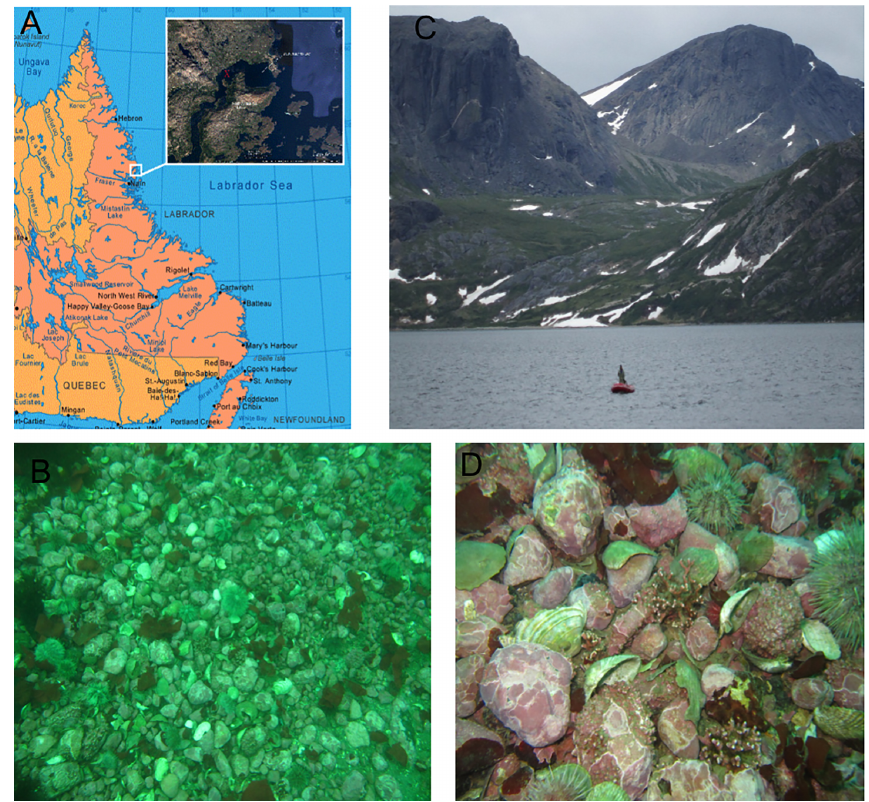
Figure 1. (a) Port Manvers Bay Station, Labrador, Canada. (b) Pebble–shell bottom with occasional rhodoliths at 15–17m. Coralline-covered pebbles range from about 5–10cm diameter. (c) Collecting site in western Port Manvers Bay. (d) Close-up of bottom shown in Fig.